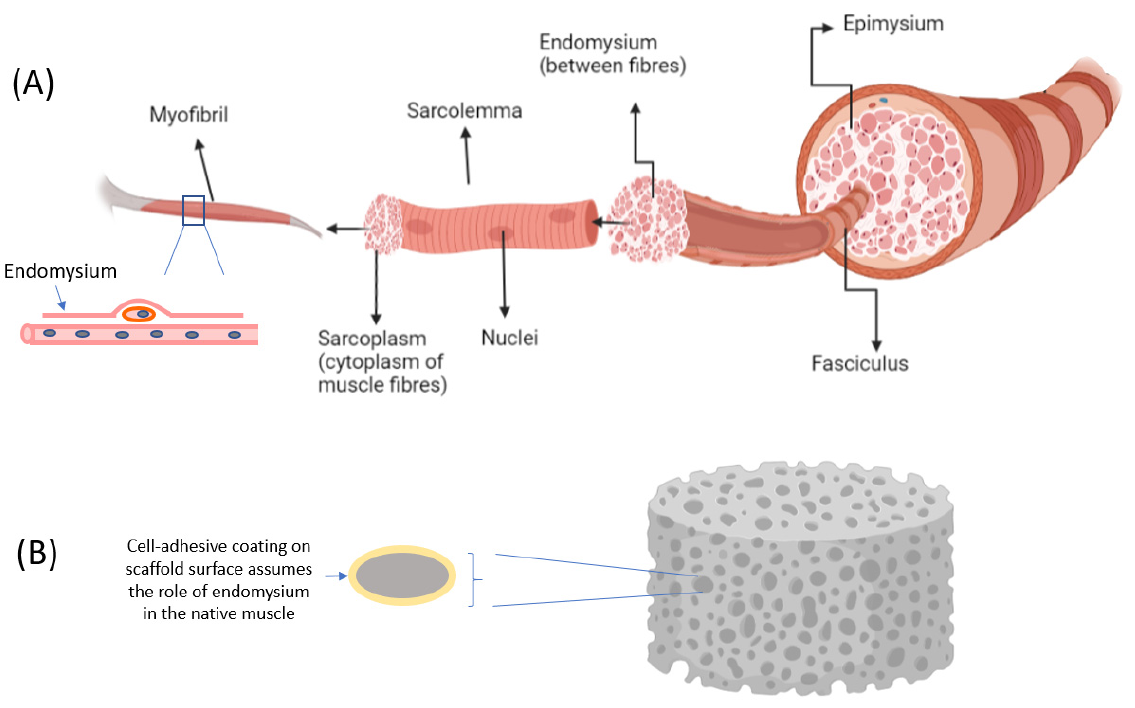
Figure 1. The role of the scaffold ( B ) in guiding muscle cell differentiation and muscle fiber devel- opment is analogous to that of muscle connective tissue layers ( A ). The extracellular matrix of the endomysium plays an important signaling role in the regeneration of muscle fibers (adhesion, dif- ferentiation, proliferation, and inhibitory cues). In scaffolds the role of regulating muscle maturation is assumed by the coatings or surface modifications of the scaffold. Collectively, the endomysium, perimysium, and epimysium define the different levels of muscle organization and structure, a role which is also assumed by tissue scaffolds.